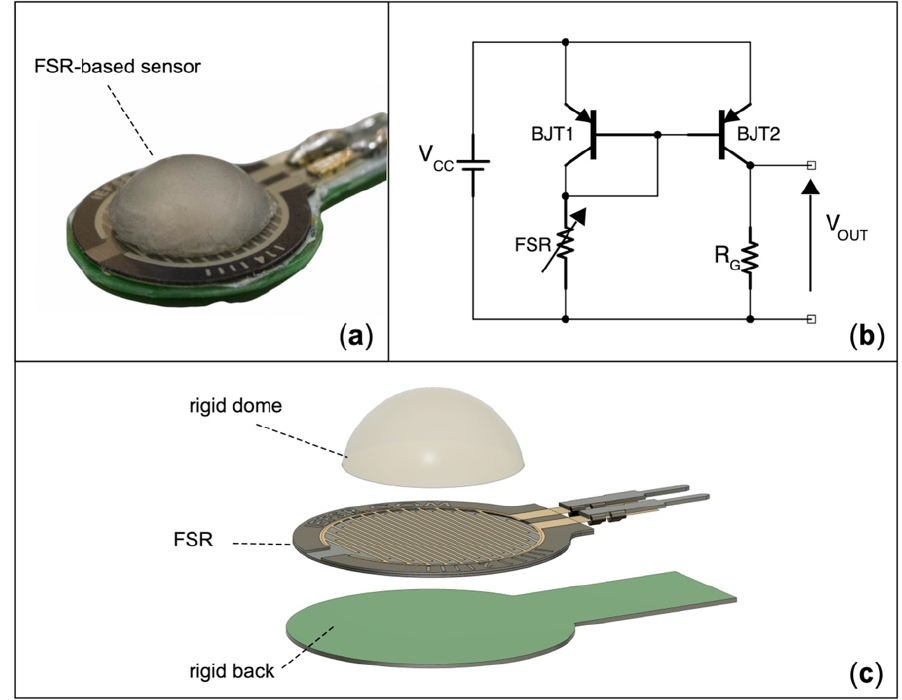
Figure 5. FSR-based sensor: ( a ) actual realization; ( b ) conditioning circuit based on current mirror (R G = 0.91 k Ω ); ( c ) exploded 3D view rendering of the sensor components. Recordings were carried out in the same setup as presented in Section 2.3. FSR-based sensor signals were compared at various stress frequencies with those obtained from the loadcell, which provided measures of the actual force impressed on the sensor. The percent errors for the various descriptive statistics (minimum, maximum, mean, and